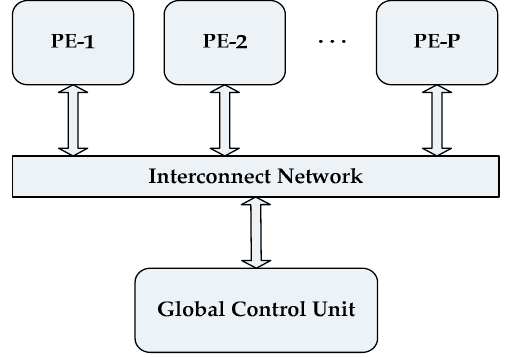
Figure 2. Top level block diagram of the proposed architecture.